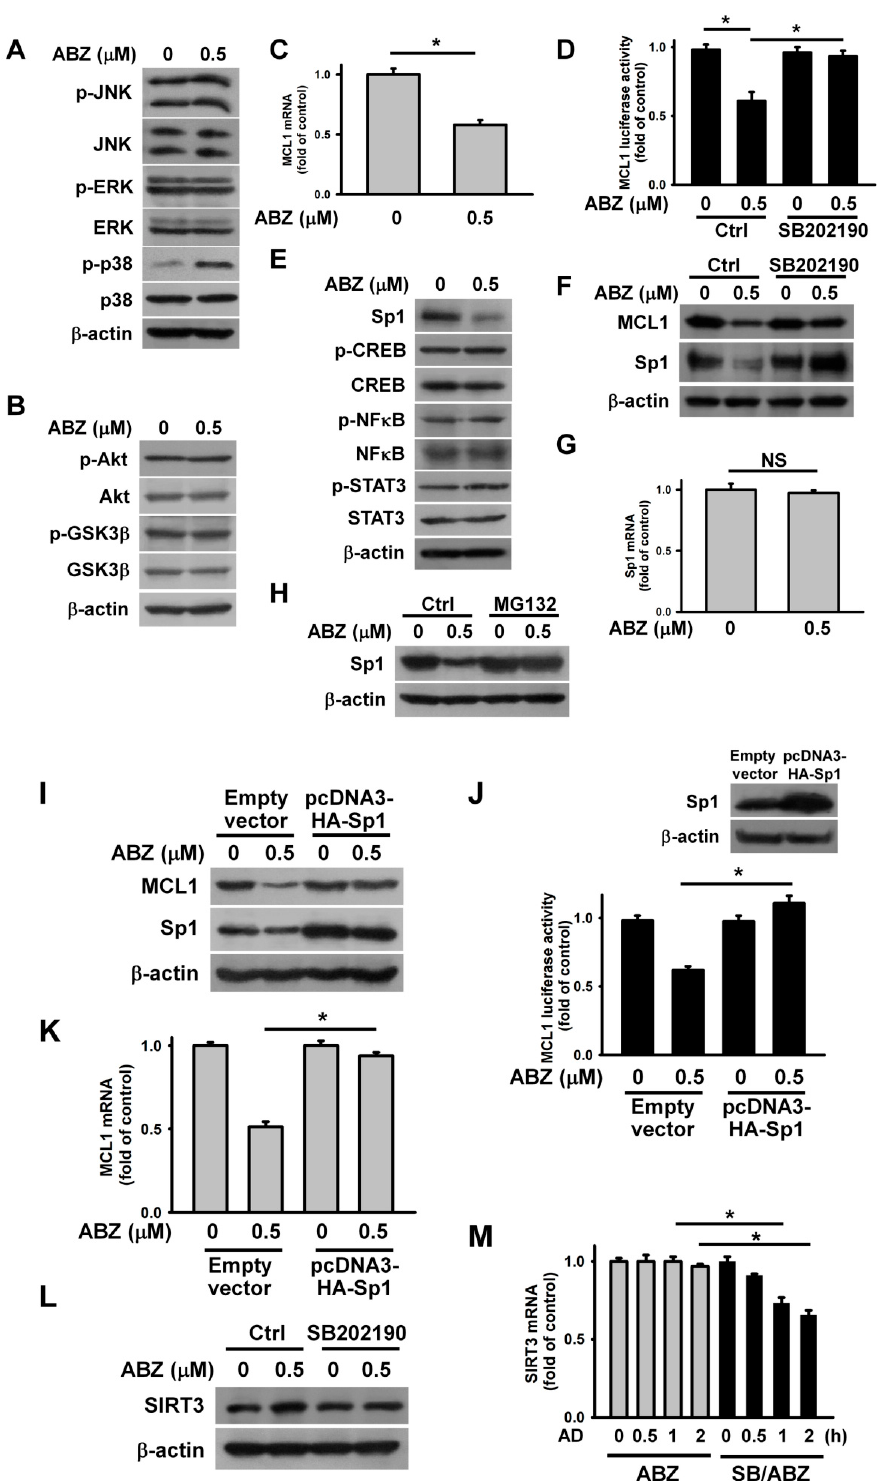
Figure 5. ABZ-induced p38 MAPK activation suppressed Sp1-mediated MCL1 transcription and increased SIRT3 mRNA stability. Without specific indication, K562 cells were incubated with 0.5 µ M ABZ for 24 h. ( A ) Effect of ABZ on MAPK phosphorylation. ( B ) Effect of ABZ on Akt and GSK3 β phosphorylation. ( C ) Analysis of MCL1 mRNA levels in ABZ-treated cells. The values represent